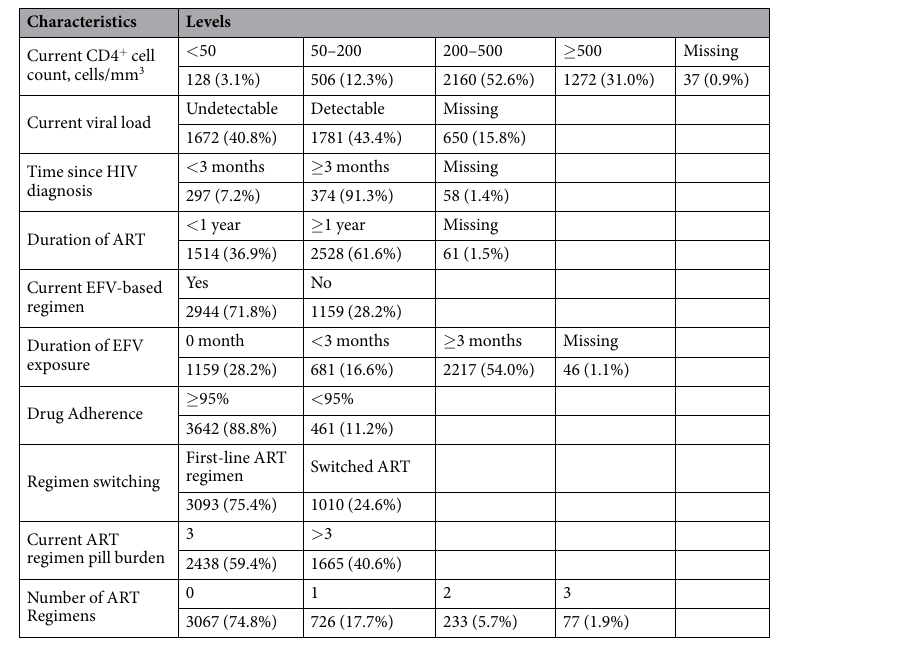
Table 2. Clinical characteristics for all 4103 subjects [n